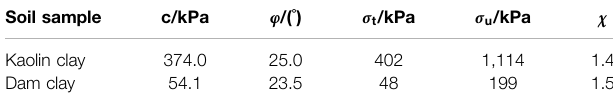
TABLE 2 | Model parameters of unsaturated soil sample.